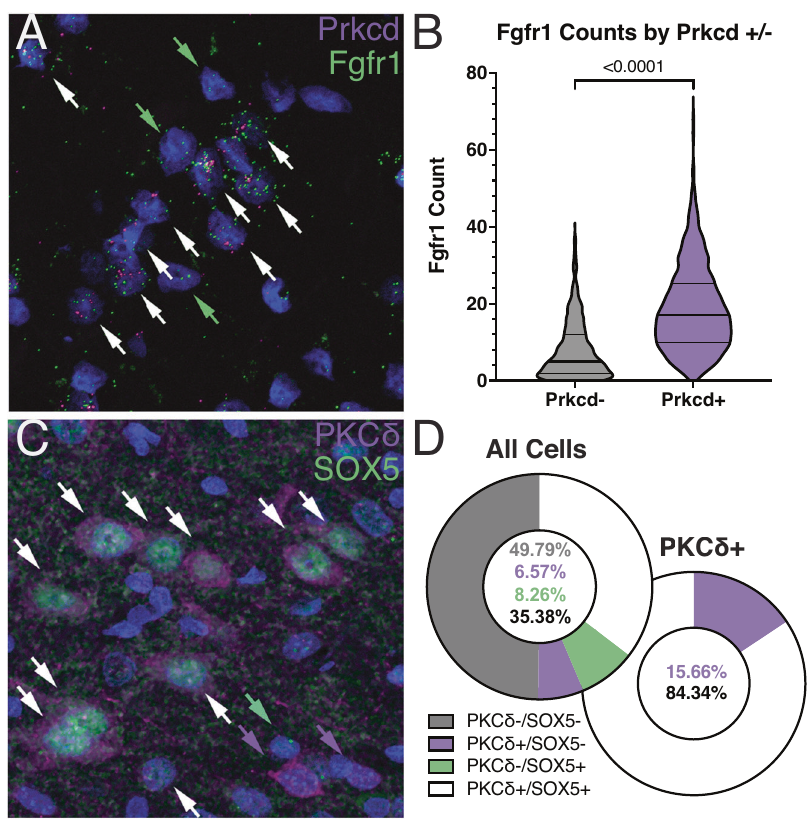
Fig. 5 Marker gene validation with RNA in situ hybridization and immunohistochemistry. A RNAscope image with Prkcd (magenta) and Fgfr1 (green) puncta and DAPI stained nuclei (blue). Double-labeled nuclei are shown with a white arrow. Twelve total cells are labeled, 9/12 coexpressing Prkcd and Fgfr1 and 3/12 only expressing Fgfr1 . All Prkcd + nuclei expressed Fgfr1 . B Violin plot of Fgfr1 expression in Prkcd + ( n = 542) and Prkcd − ( n = 833) cells from CIE and air exposed animals. Cells that contained ≥ 3 Prkcd puncta were de fi ned as Prkcd + . Prkcd